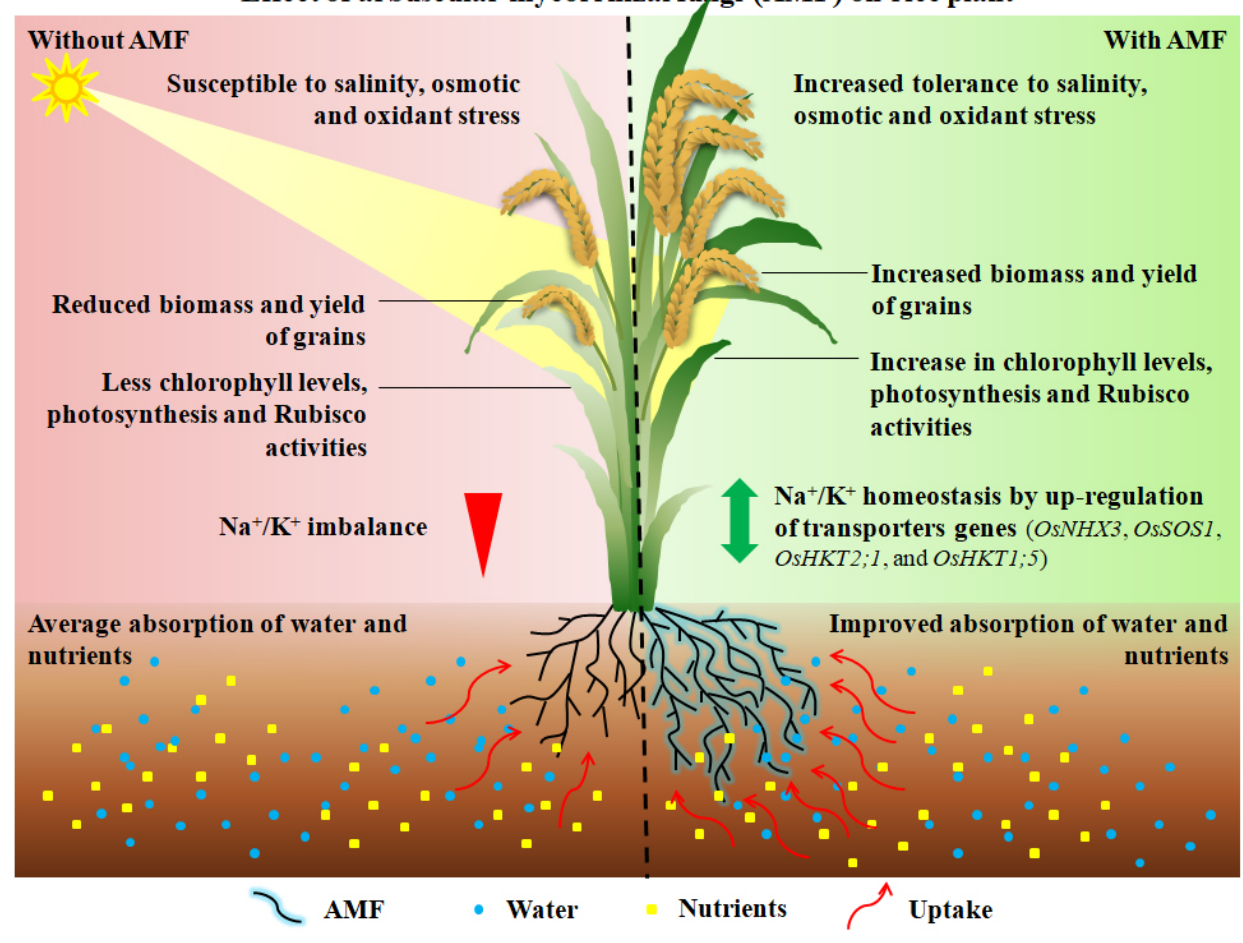
Figure 5. Effect of AMF on rice under saline stress condition. Differential responses with AMF and without AMF rice plants under saline stress. Na + and K + imbalance affects the plant's physiological traits. AMF improves the water and essential nutrients uptake by roots, up-regulates the transporters, and also maintains the Na + and K + homeostasis. Salinity stress negatively affects photosynthesis, Rubisco activities, biomass, and yield. AMF positively regulates photosynthesis, Rubisco activities, biomass, and yield under salt stress conditions. Overall, AMF enhances the performance of the rice plant during saline